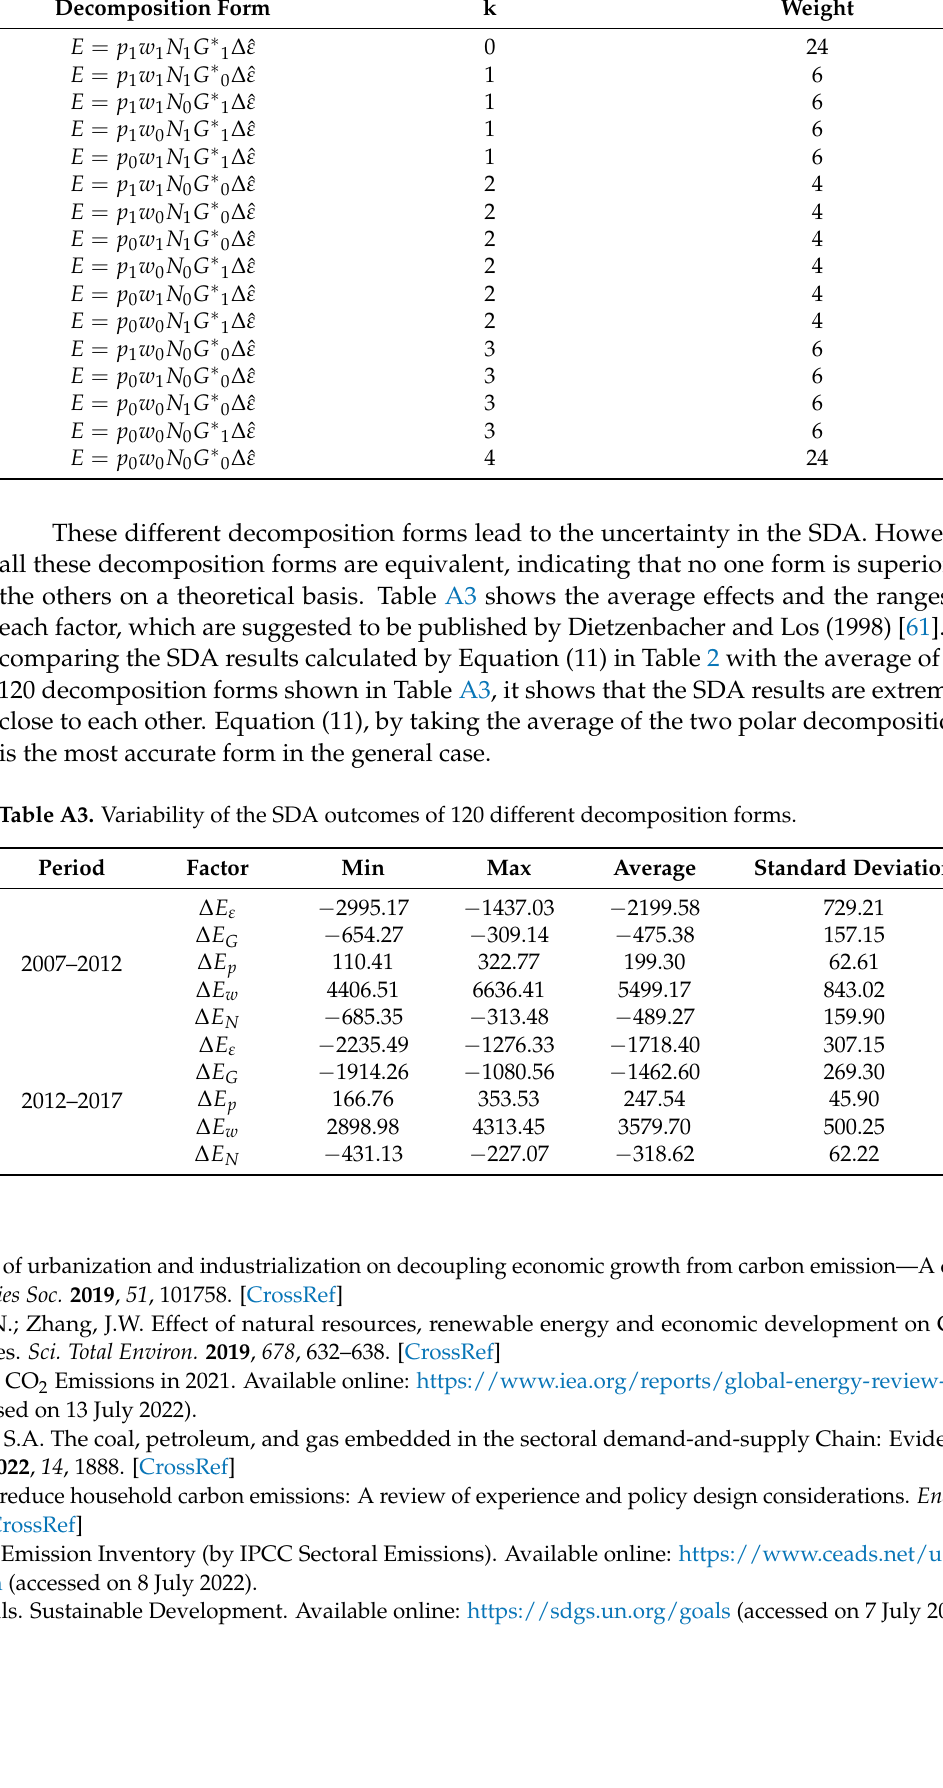
Table A2. The decomposition form of carbon emission intensity. Decomposition Form